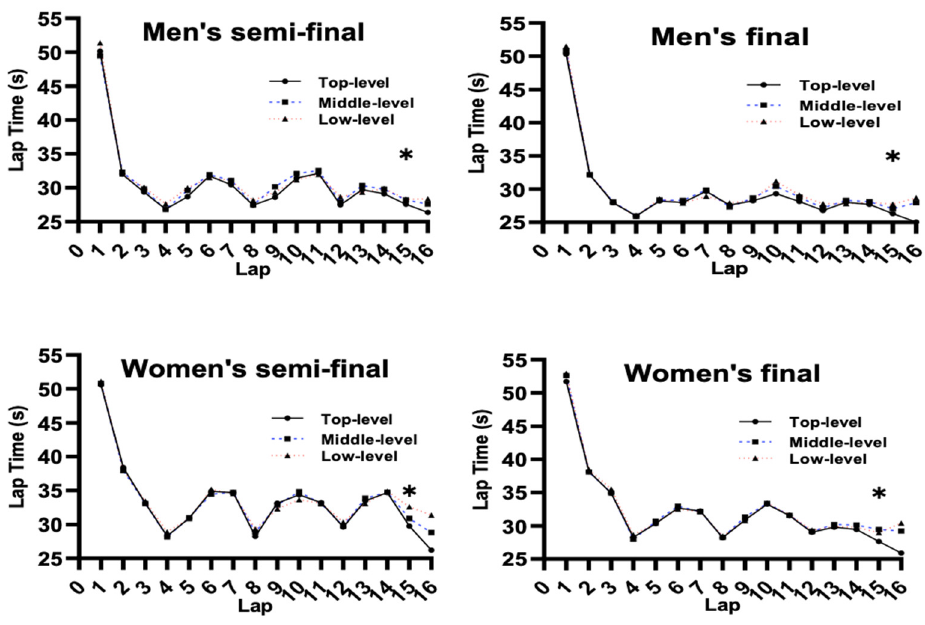
Figure 6. Comparison of lap time spent among G, CS, and SL. Note: * marked values were significant when p ≤